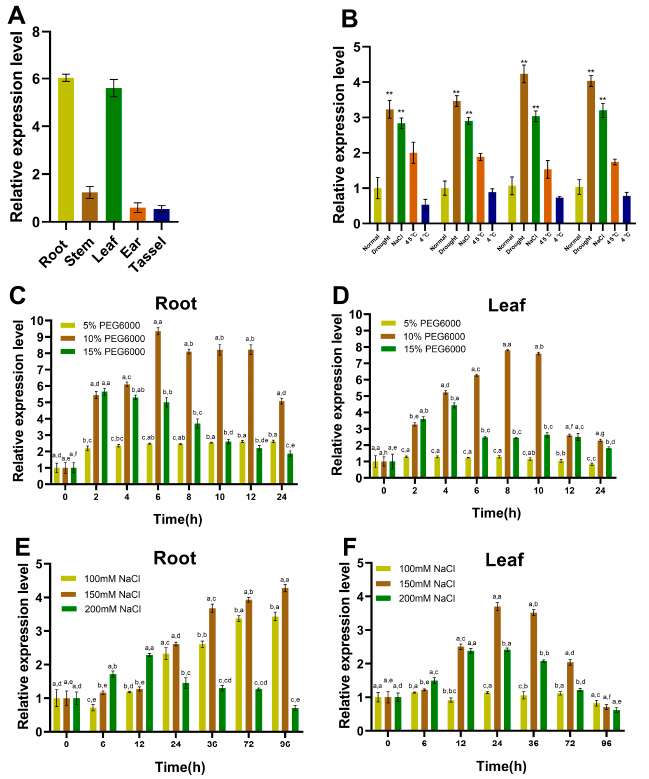
Figure 1. Expression analysis of ZmSRG7 . ( A ) tissue site expression analysis of ZmSRG7 . ( B ) response of ZmSRG7 to abiotic stress. ( C – F ) expression of ZmSRG7 in roots and leaves. Values are mean ± SD of three biological replicates. Bars with different letters are significantly different at p < 0.05 according to Duncan’s multiple range tests. p < 0.05 (**). 2.2. Subcellular Localization of ZmSRG7 Transient expression of ZmSRG7-GFP was performed in tobacco leaves with the pur- pose of observing the subcellular localization of ZmSRG7 . The green fluorescence signal produced by the control vector GFP was visible everywhere. On the other hand, the ZmSRG7-GFP signal was only seen on the nucleus of the cell (Figure 2). This finding was in line with what was anticipated.